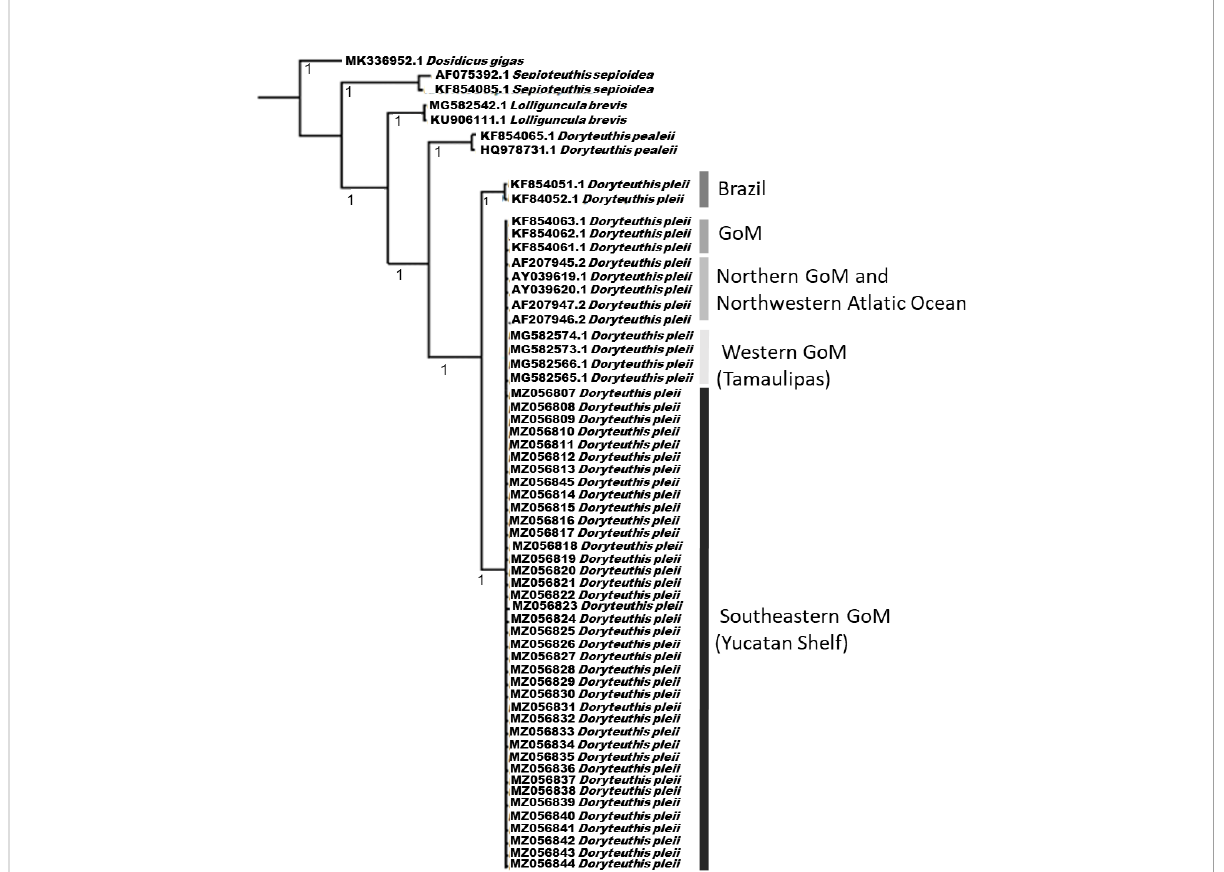
FIGURE 3 D. pleii phylogenetic tree comparing representative sequences of the species in other geographic regions and the sequences of other three loliginid species that occur in the same distributional area. Dosidicus gigas is used as an outgroup. The posterior probability values are plotted on each resolved